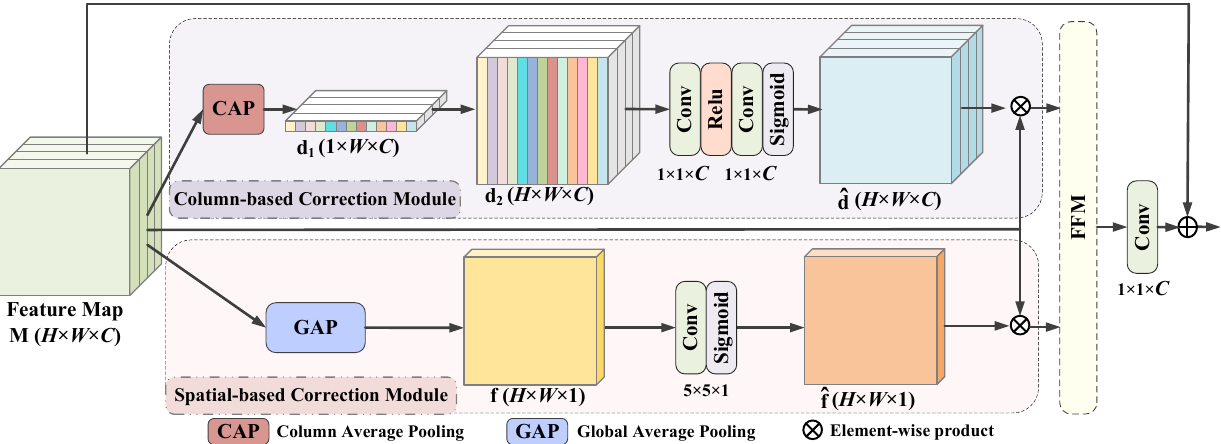
Figure 2. The structure of the column-spatial correction module (CSCM). The CSCM consists of the column-based and spatial-based correction modules (CCM and SCM), which were designed from the perspectives of reducing local differences and improving global uniformity, respectively. FFM is used to fuse features generated by CCM and